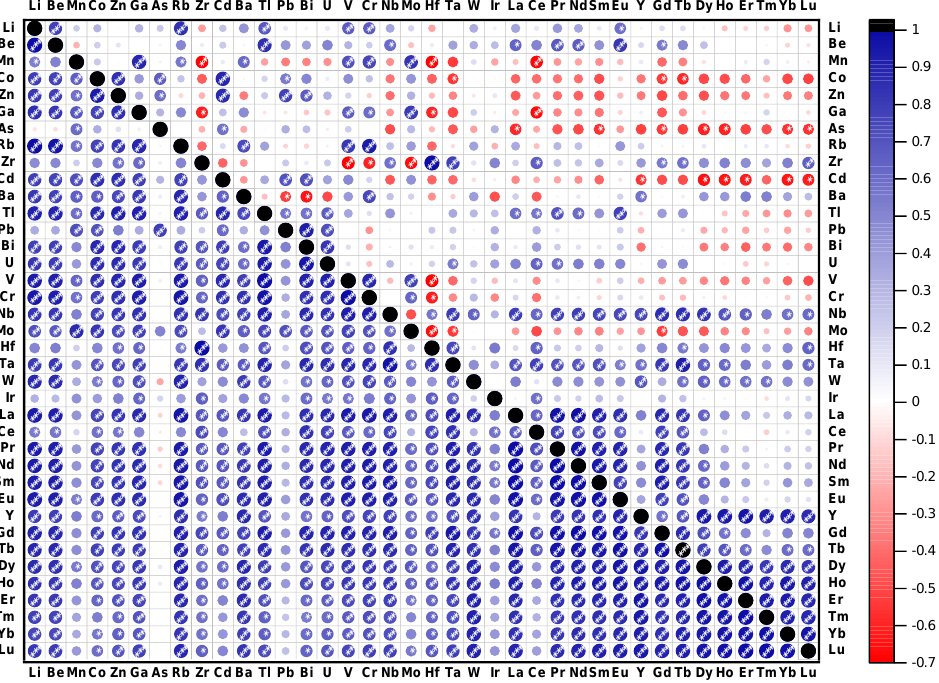
Figure 5. Pearson correlation coefficient matrix for the relationships between the element concen- trations in the Podu Iloaiei Dam Lake sediment in July (left) and October (right). The color and the diameter of the circles are related to the correlation coefficient value (according to the color scale on the right) and the p -value (inversely proportional), respectively. The number of white stars is related to the p -value: * ( p < 0.05), ** ( p < 0.01), and *** ( p < 0.001)” .